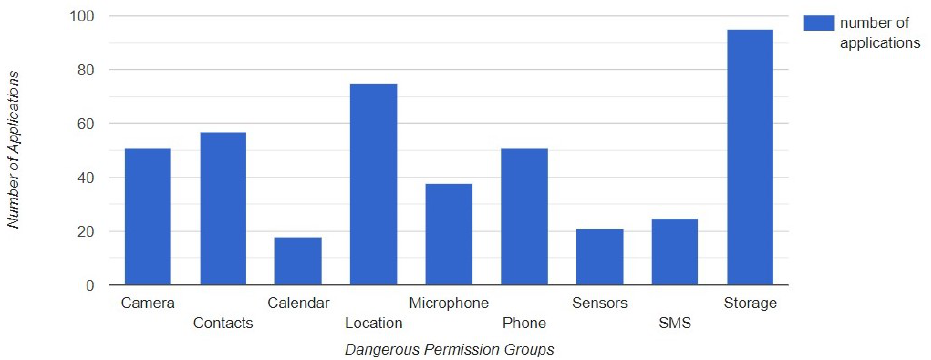
Figure 7. Number of applications using permissions in each dangerous